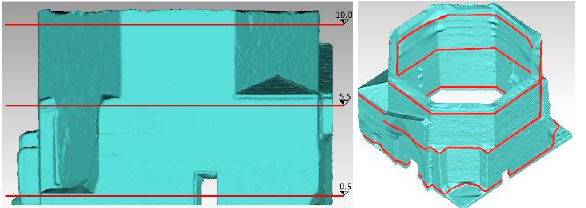
Figure 8. The polygonal model of the baptistery, with the overlay of the three horizontal sections (red) at three different levels. Frontal view (left) and perspective view (right)